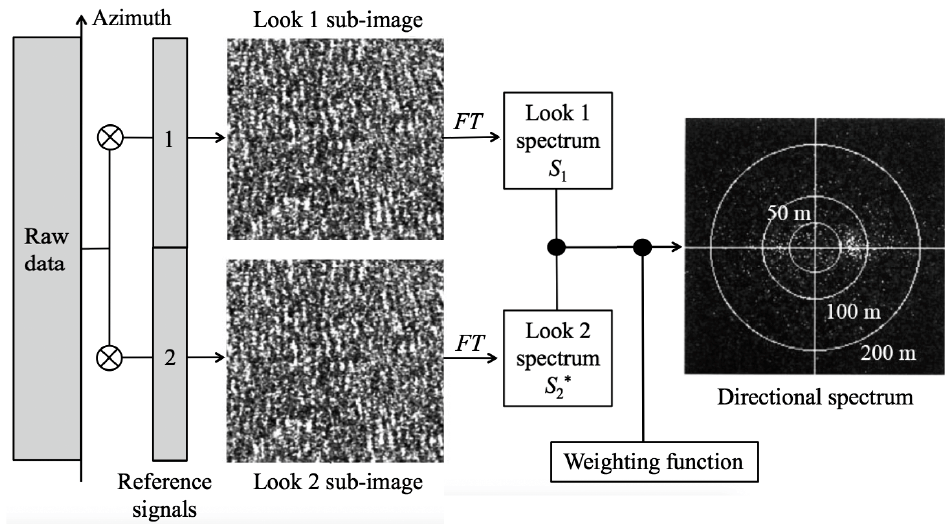
Figure 5. Measurement of directional wave spectrum using the method of weighted cross–spectra.